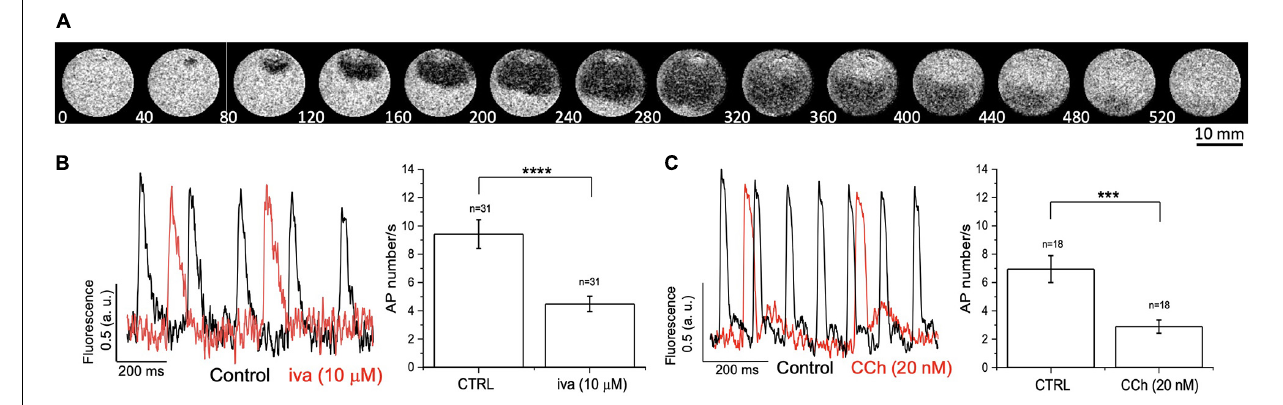
FIGURE 10 | Effect of ivabradine and carbachol on spontaneously beating hiPSC-CMs. (A) Representative fluorescence imaging of spontaneous AP propagation in a hiPSC-CM monolayer during a 520 ms recording. (B,C) Spontaneous AP traces recorded in hiPSC-CM monolayer in the absence (black lines, CTR) and presence (red lines) of ivabradine (Iva, 10 µ M) or carbachol (CCh, 20 nM). Histograms represent AP number/s, expressed as mean ± standard error of the mean, before and after Iva or CCh treatment. **** p < 0.0001 CTRL vs. Iva (10 µ M); *** p < 0.001 CTRL vs. CCh (20